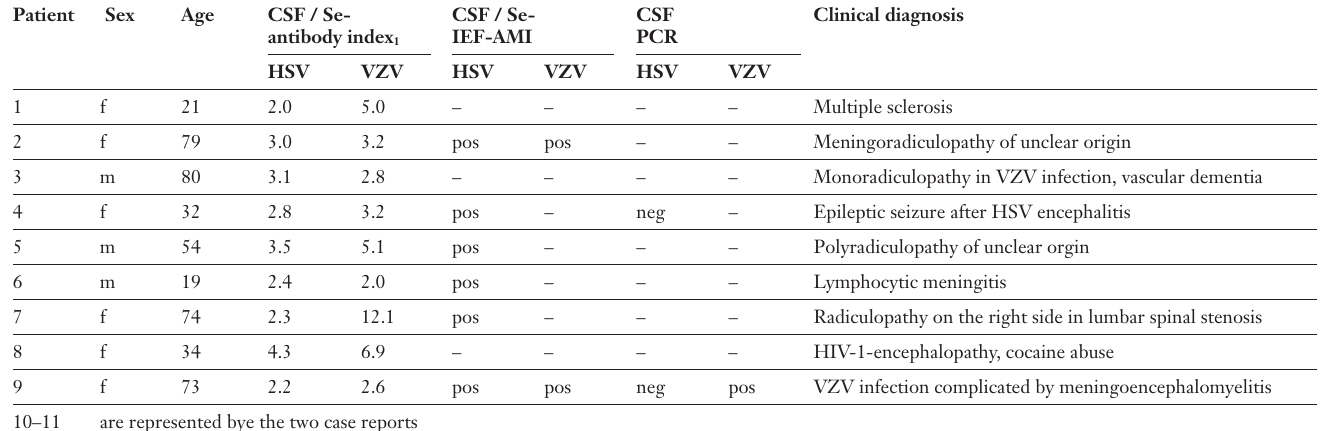
Laboratory results of eleven patients with coincidental intrathecal production of HSV and VZV specific antibodies.